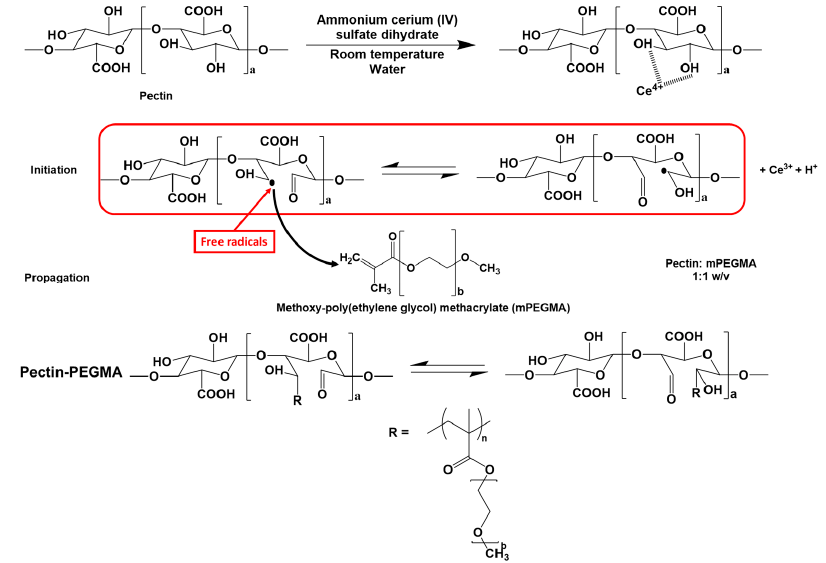
Figure 1. Mechanism of cerium-initiated radical polymerization.